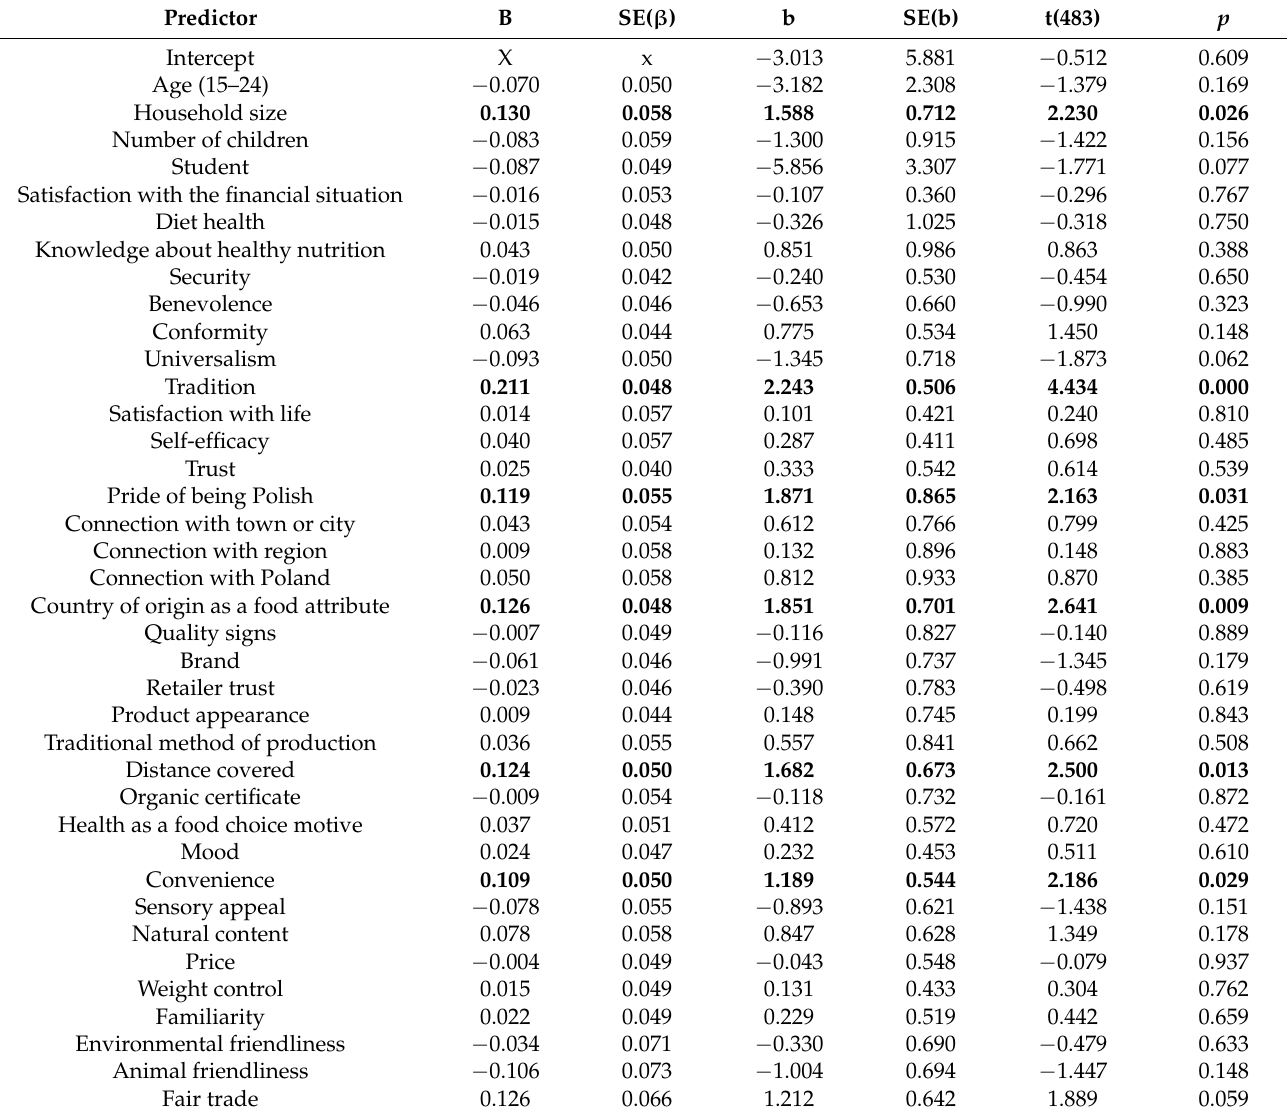
Table 9. Selected predictors of consumer ethnocentrism in the food market among women (a multiple regression model). Predictor